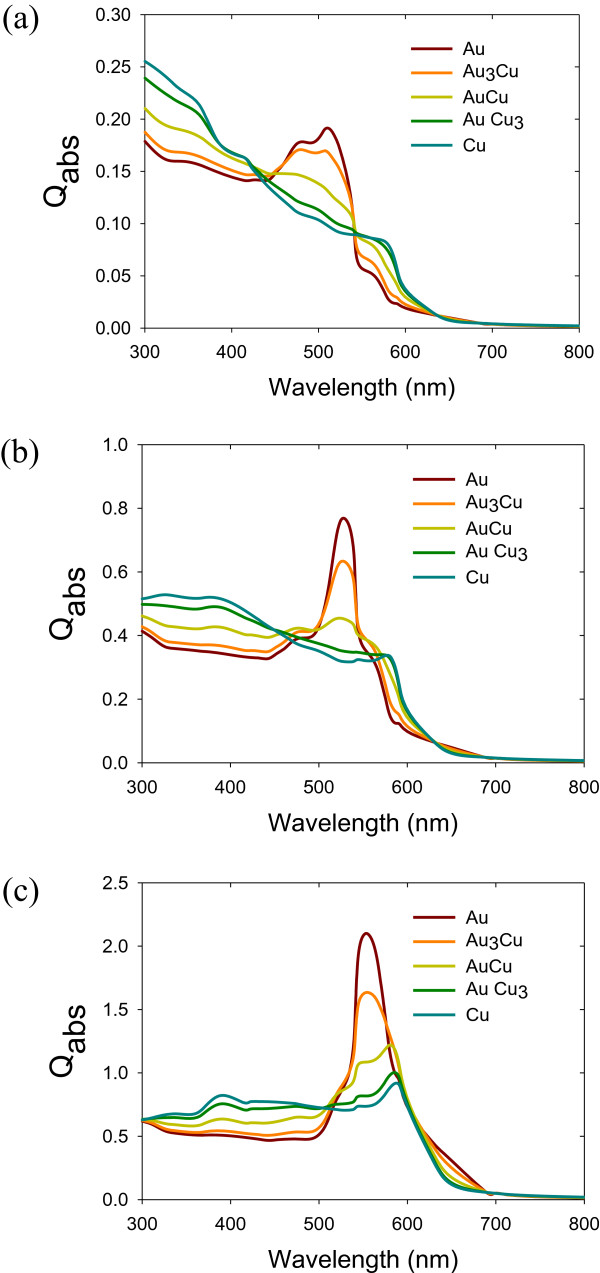
Extinction of Au-Cu alloy nanoparticles. Extinction of Au-Cu alloy nanoparticles (10 nm) when (a)n = 1, (b)n = 1.4, and (c)n = 1.8 (Qabs is the extinction coefficient).